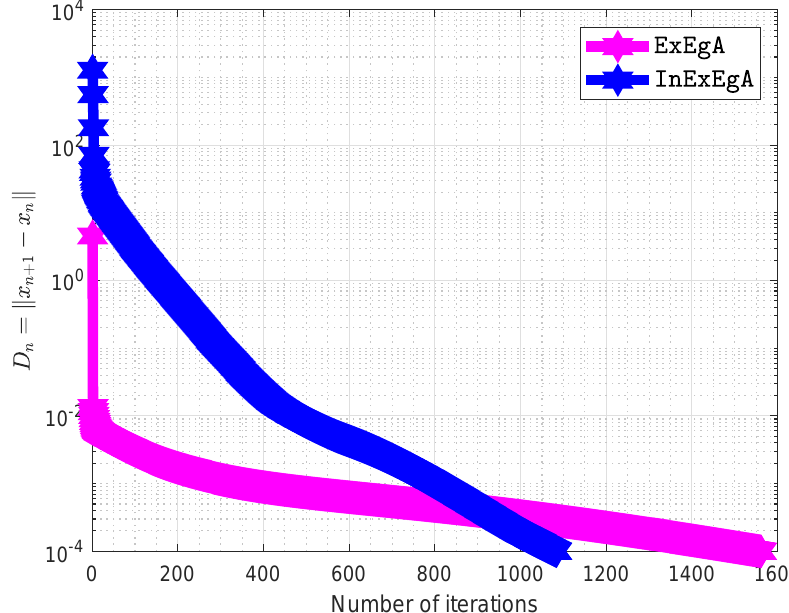
Figure 11. Algorithm 1 comparison with Algorithm 1 in [16] when m = 20.